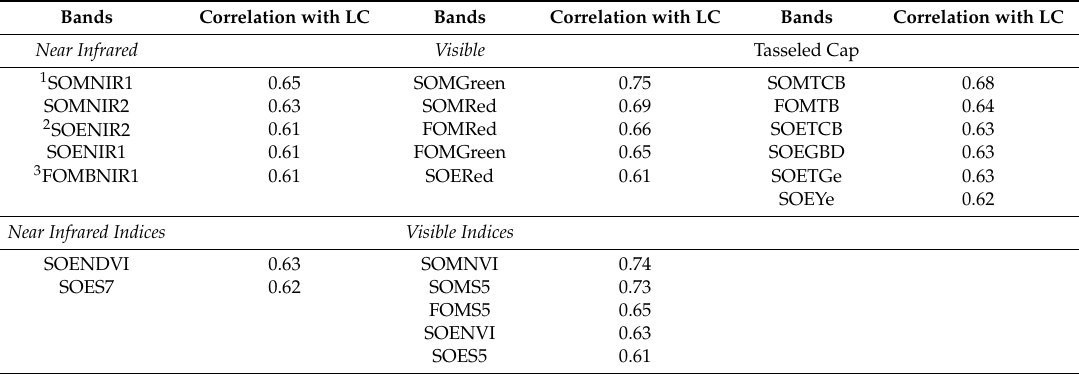
Table 3. Pearson’s correlation coefficients between LC and Landsat MSS based predictors. Bands Correlation with LC Bands Correlation with LC Bands Correlation with LC Near Infrared Visible Tasseled Cap 1 SOMNIR1 0.65 SOMGreen 0.75 SOMTCB 0.68 SOMNIR2 0.63 SOMRed 0.69